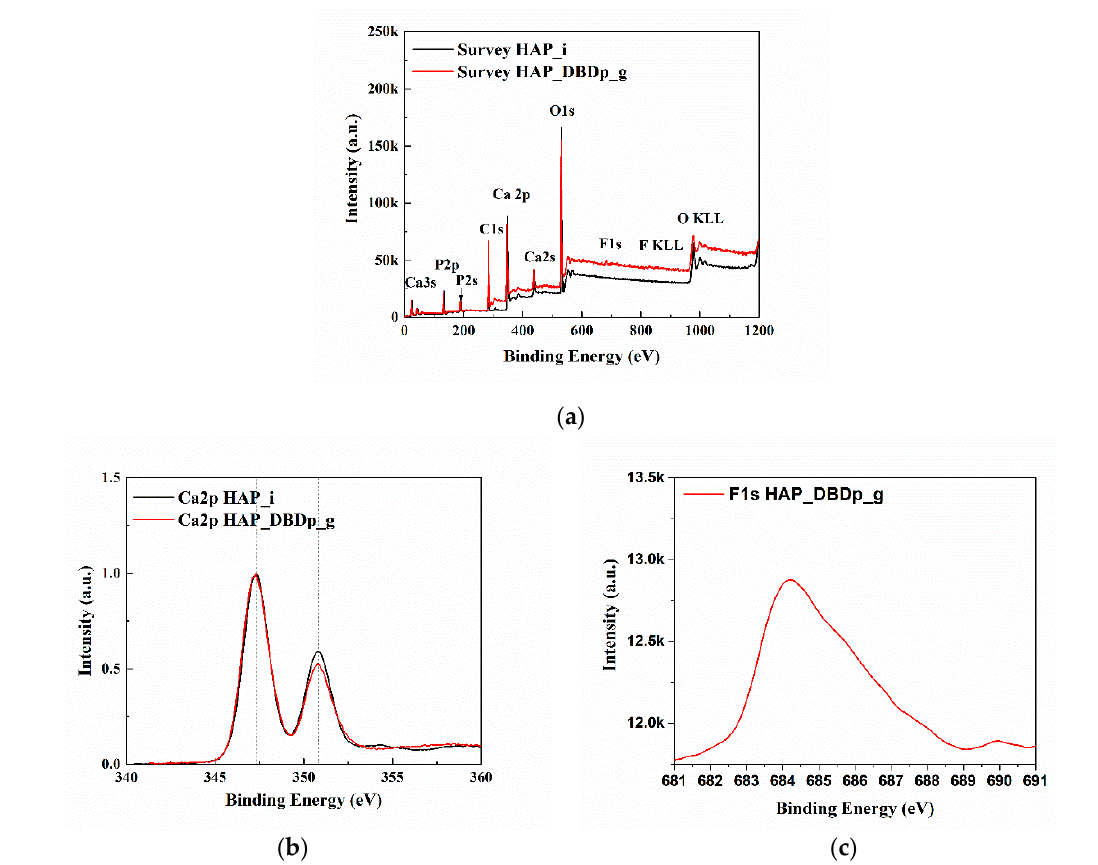
Figure 3. XPS spectra: ( a ) survey spectra; ( b ) high-resolution spectra of the Ca2p region; ( c ) high-resolution spectra of the F1s region. Table 2. XPS results of HAP_i and